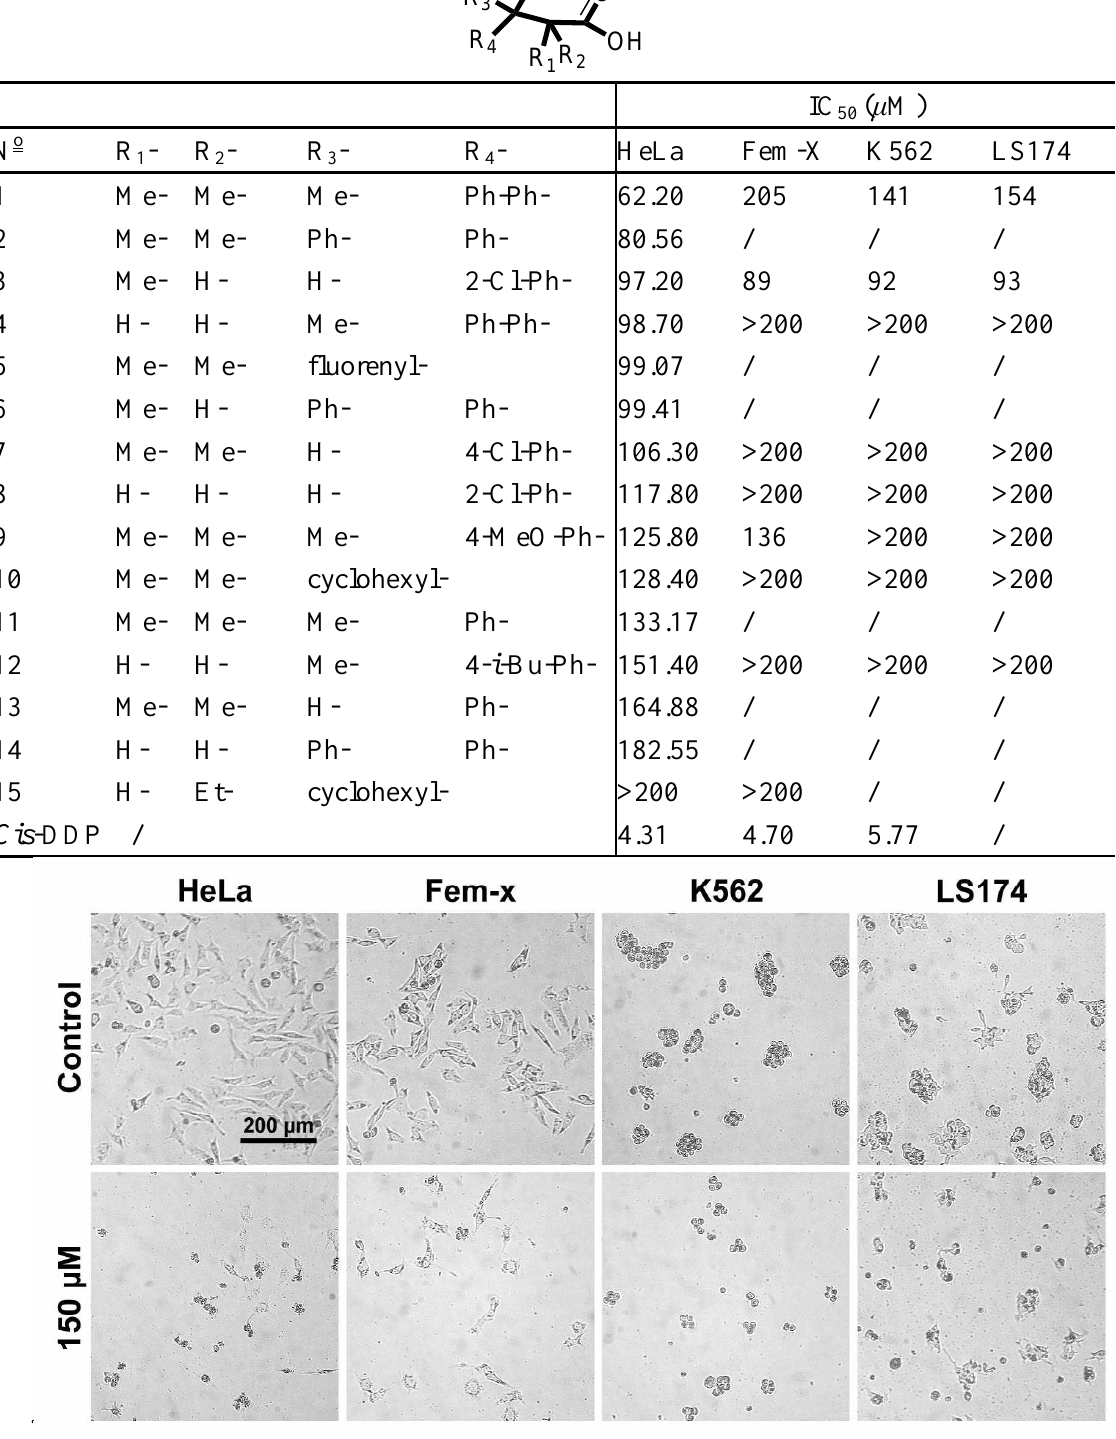
Figure 1. Light microscopy of four studied cell lines after treatment for 72 h with medium alone (control, upper row), or with 150 µ M of compound 1 (bottom row). Cells were observed using an inverted microscope and photographed by a digital camera (Olympus C-4040